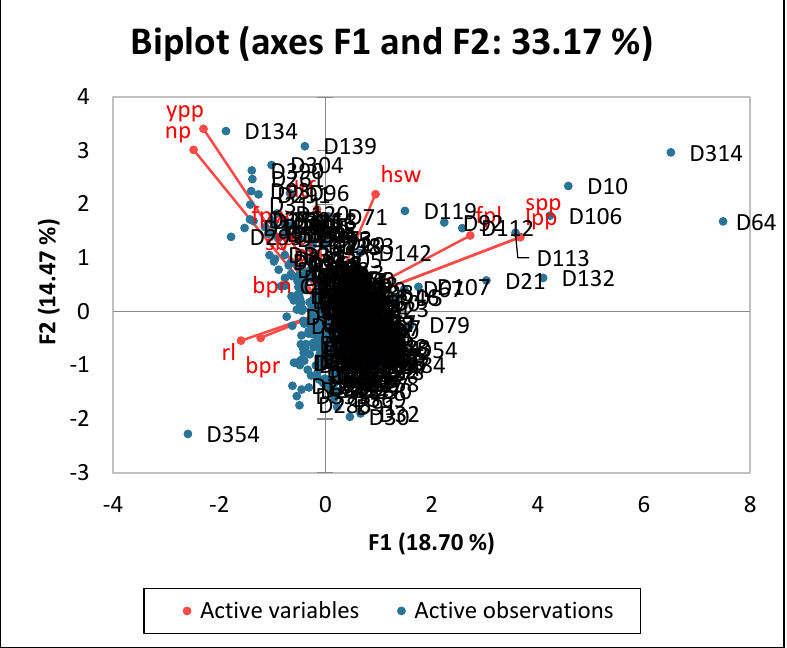
Figure 6. Scatter plot diagram of principal component analysis of quantitative traits of lablab.